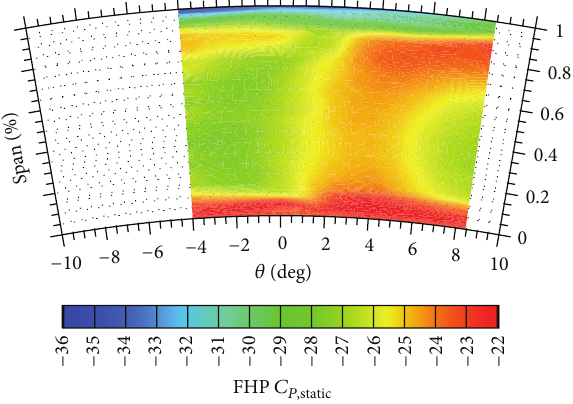
Figure 18: FHP coefficient of static pressure, intraspace.